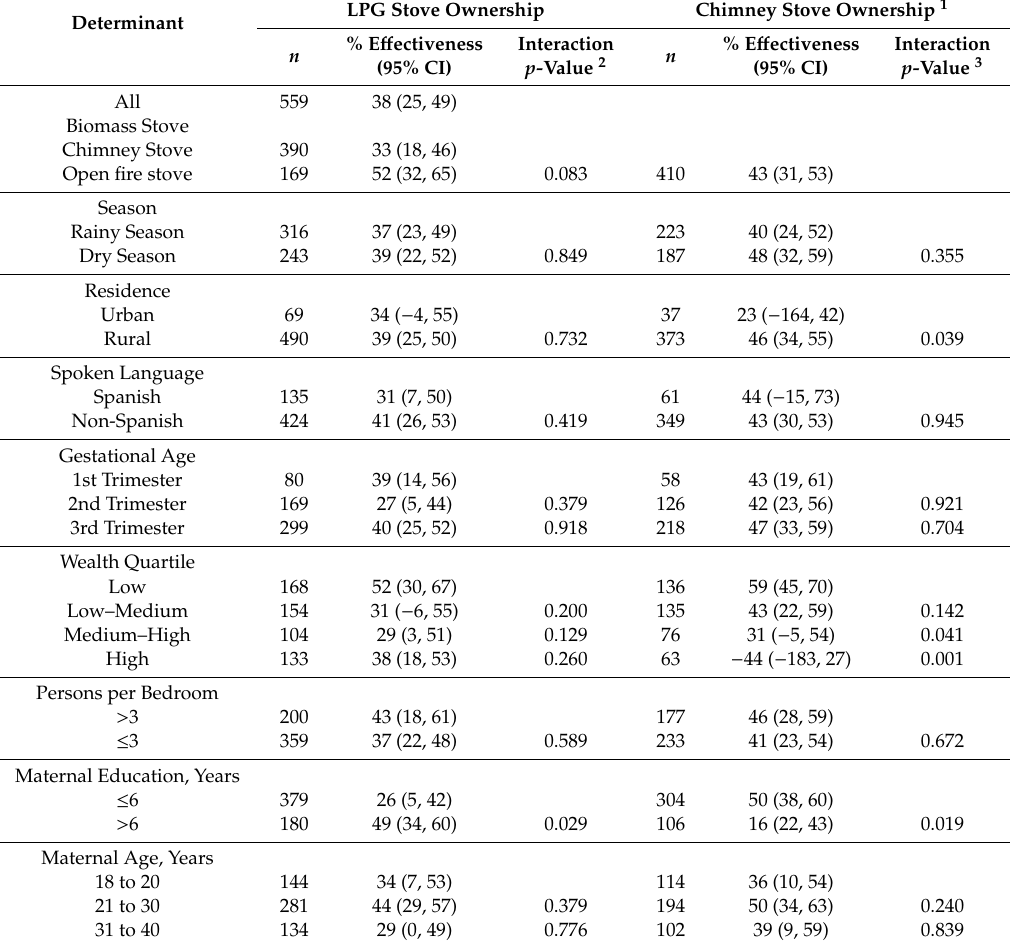
Table 5. Determinants of the e ff ectiveness of LPG and chimney stove ownership on the reduction of personal exposure to PM 2.5 in pregnant women ( n =